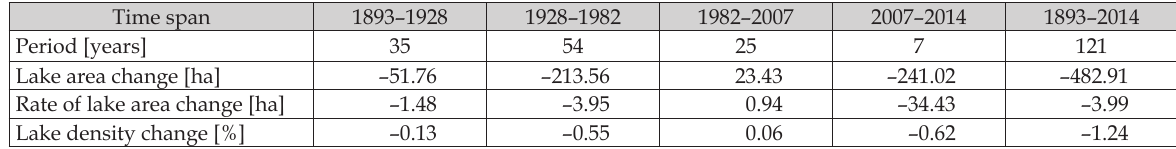
Table 3. Lake area and density changes for total data of the Iława Lakeland Landscape